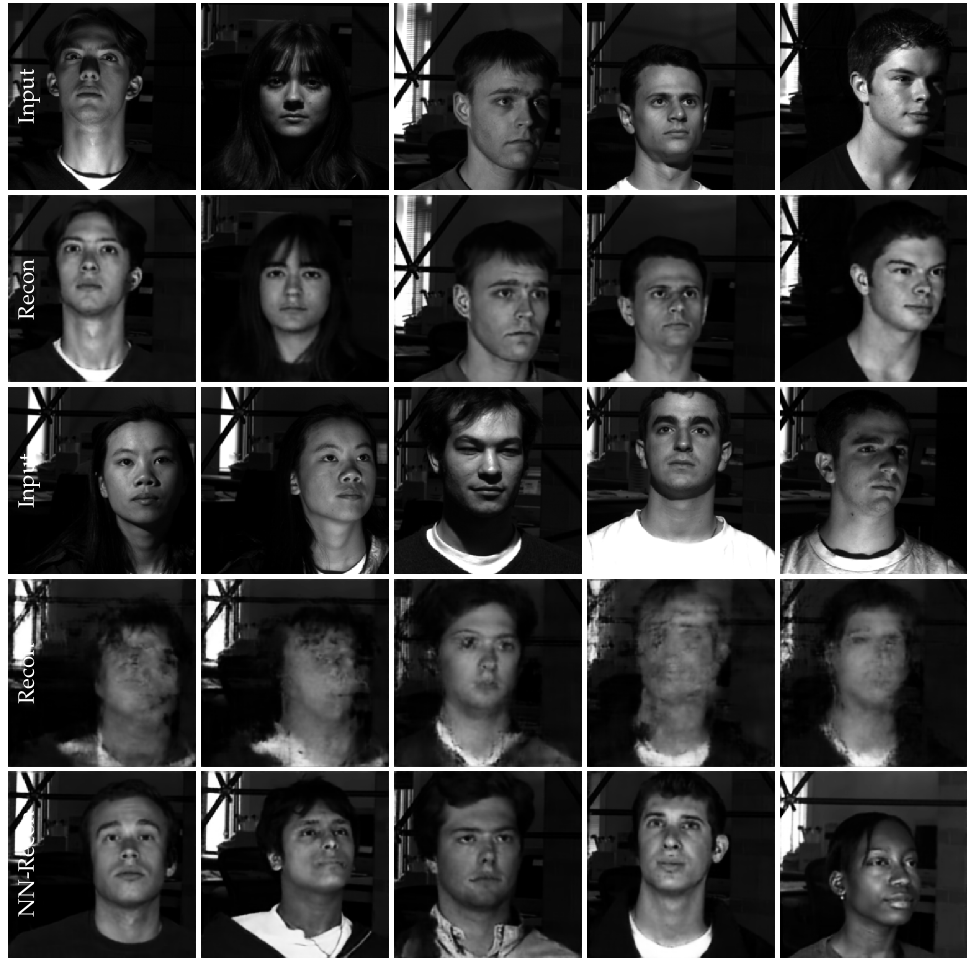
Figure 5. Extended Yale Face Database B. Illumination is removed from the training samples (first row) to form the reconstruction (second row). The test samples (third row) cannot always be reconstructed reliably (fourth row). Reconstructing the nearest neighbour (fifth row) preserves the head pose and position and removes the illumination such that potentially a classification or a landmark detection could be performed on the latter instead of the input